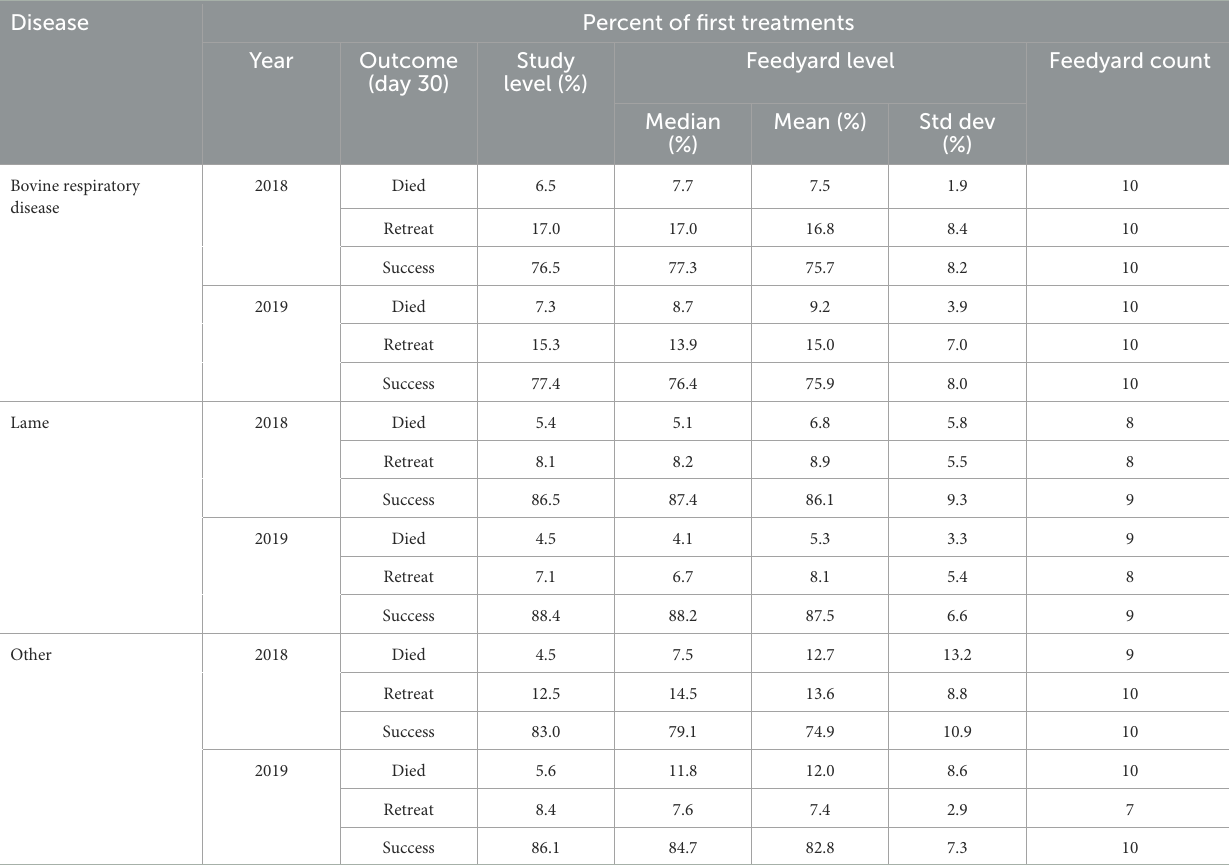
TABLE 10 Day 30 outcomes after individual animal treatment for bovine respiratory disease, lameness, and other indications.